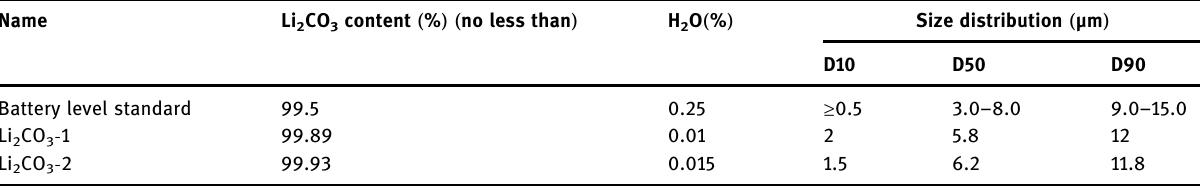
Table 1: Purity, particle size, and water content of the Li 2 CO 3 standards and the products Name